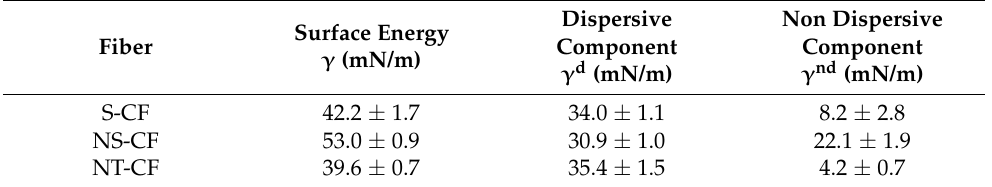
Table 7. Dispersive and non-dispersive components and total surface energies of